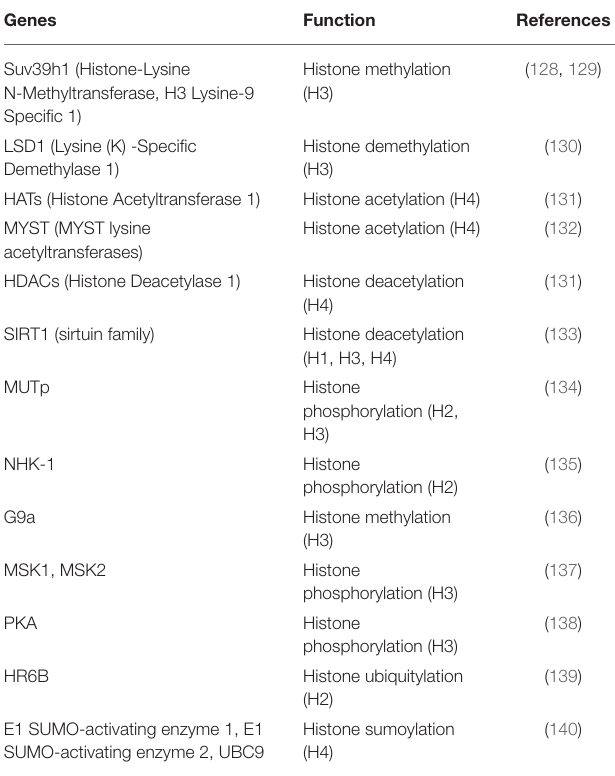
TABLE 2 | Selected molecules involved in post -translational histone modification in relation to